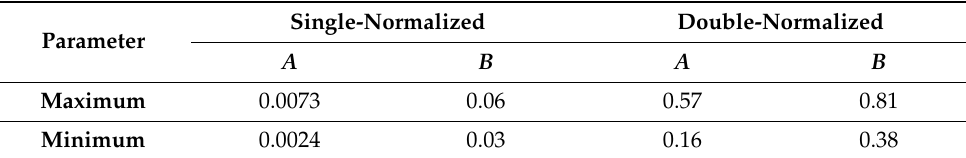
Figure 8. Diagram of ( a ) Single- and ( b ) Double-normalization for dense sand. Experiments per- formed by [25,27,30]. Table 5. Maximum and minimum values of dense sand.